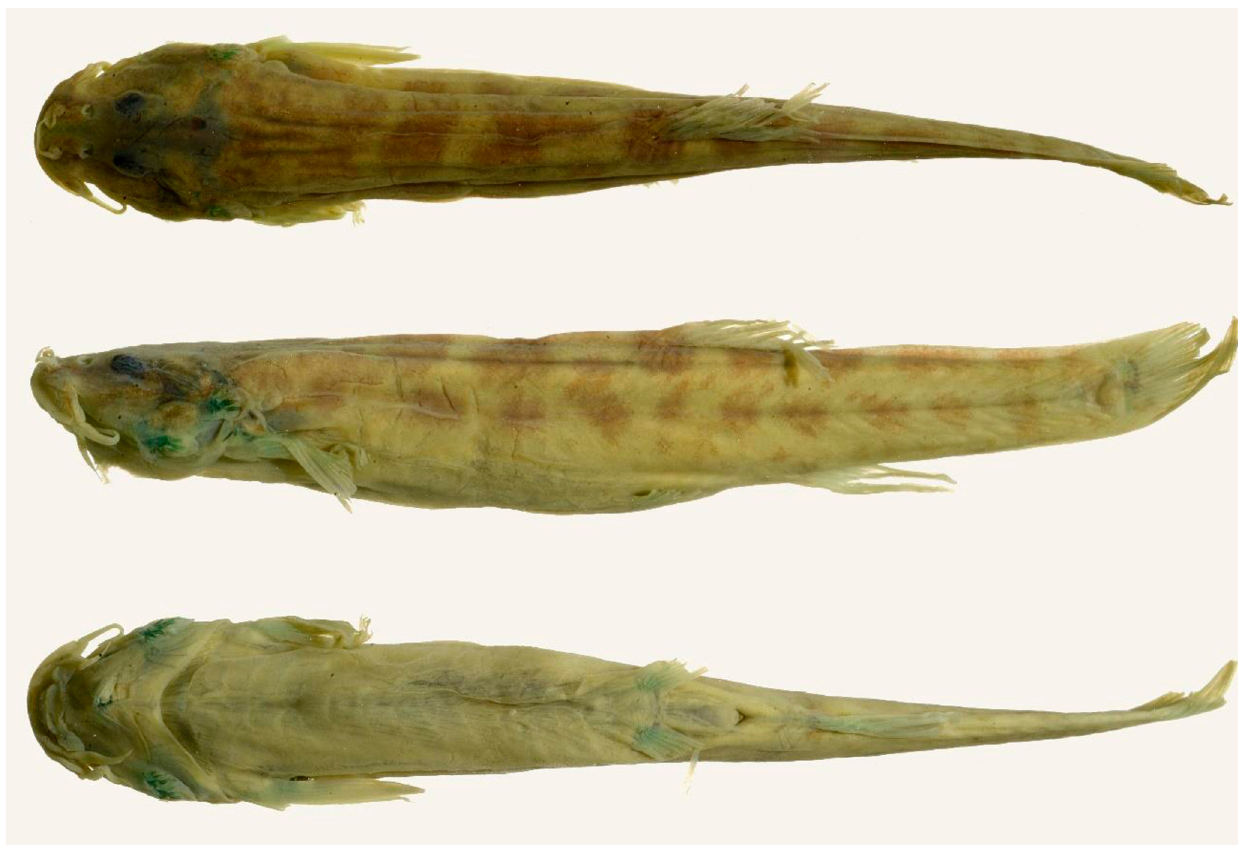
FIGURE 19 | Scleronema minutum , paratype of Pygidium angustirostris (BMNH 1944.6.20.1; 34.5 mm SL), Uruguay, Paysandú, cañada de las Piedras Blancas, tributary to río Queguay, lower rio Uruguay. Photograph taken by Sandra